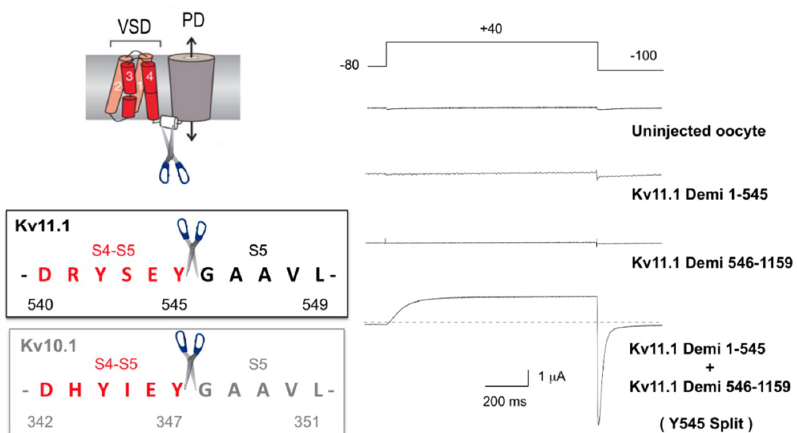
Figure 2. Physical continuity between the voltage-sensing and the pore modules is not necessary for KCNH (Kv11.1-hERG and Kv10.1-eag1) channel functional expression. A scheme of the transmembranal core of a channel subunit is shown on the upper left corner. The aminoacid sequence of the S4-S5 linker region and the point at which the covalent link between the VSD and the PD is interrupted to generate S4-S5 split channels is shown on the lower left part. Electrophysiological recordings of Kv11.1 (hERG) N- and C-terminal demi-channels injected alone or together in Xenopus oocytes bathed in 50 mM high-K + medium and submitted to the voltage-clamp protocol indicated on top of the traces are shown on the right. Note the presence of typical hERG outward current traces during the depolarizing step and the prominent inward tail upon repolarization, only when the amino and carboxy channel halves are combined. Modified from [25].